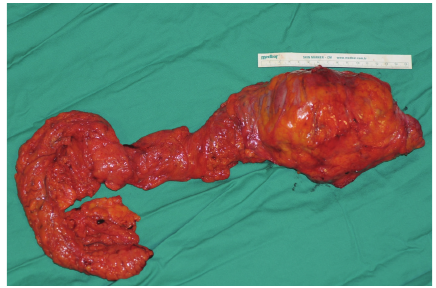
Figure 2: Resected